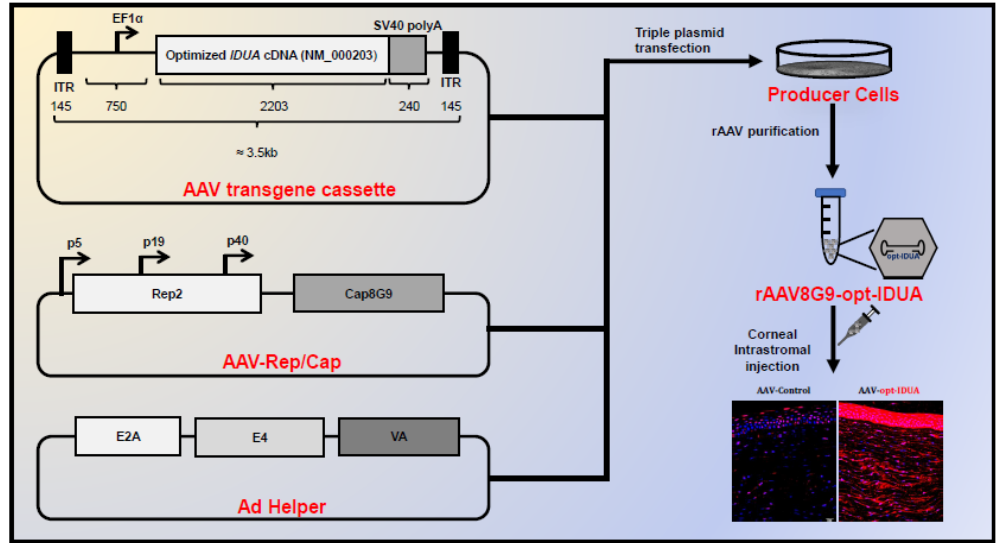
Figure 1. Outline of the AAV vector design, production, and transduction of the canine cornea. Triple transfection protocol is utilized to replicate and package the optimized IDUA expression cassette harboring EF1α promoter and SV40 polyA flanked by ITR inside cap8G9 using Hek293 producer cells. After purification AAV8G9-opt-IDUA virions (or AAV8G9-GFP control vectors) are delivered to the cornea by intrastromal injection in a canine model. Immunofluorescence staining for IDUA (red) was performed on histological sections 8 months post-injection and on-target expression of recombinant IDUA is observed in corneal